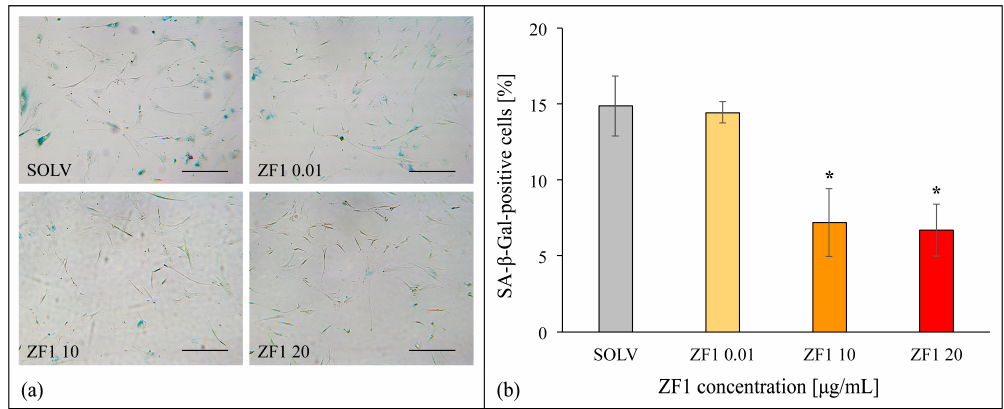
Figure 4. E ff ects of di ff erent concentrations of ZF1 on SA β -gal activity in hASCs. The hASCs (culture passages 5th–7th) were seeded in 6-well plates and were cultured in the presence of 0.01, 10, and 20 µ g / mL ZF1, or a solvent as a control for 72 h, then processed for SA β -gal assessment. ( a ) Images represent hASCs after SA β -gal staining. SA β -gal positive cells are blue. The scale bar corresponds to 200 µ m; ( b ) Positive (blue) and negative (not colored) cells were counted in at least three random fields for each technical replicate under the microscope (200 × magnification and bright field illumination). Data represent the percentage of SA β -gal positive cells calculated as the number of positive cells divided by the total number of counted cells multiplied by 100 (percentage of blue cells ± SD, n = 3, statistical significance was calculated using the Student’s t -test, * p < 0.05). Consistent with the experiments assessing the effect of ZF1 on SA β -gal activity, hASCs (isolated from one subject) and treated with ZF1 at 0.01 μ g/mL concentration showed a gene expression value of the catalytic subunit of telomerase ( TERT ) similar to that of control cells (SOLV). In contrast, hASCs exposed to both 10 μ g/mL and 20 μ g/mL ZF1 resulted in a similar statistically significant increase in TERT transcription as compared with the control hASCs (SOLV) (Figure 5).